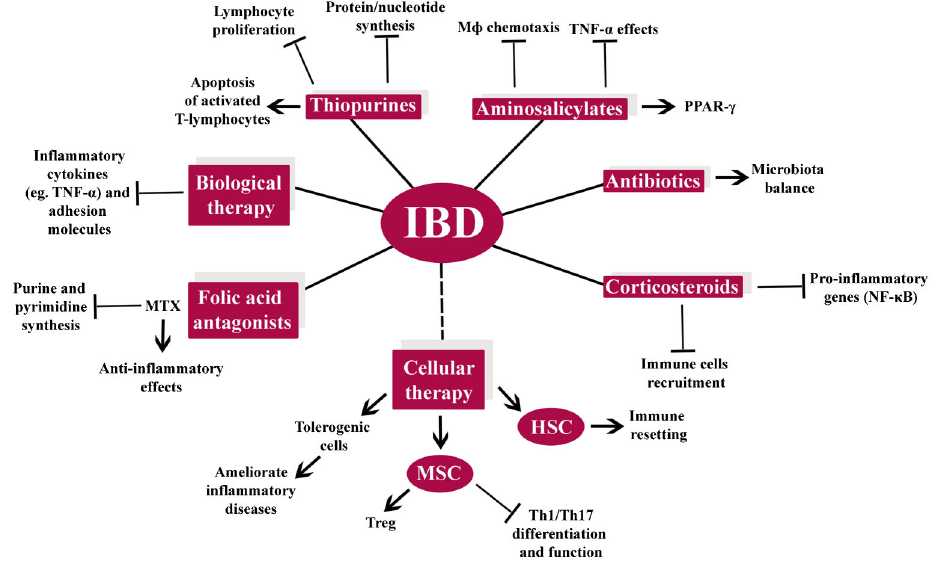
Figure 1. Current and emerging therapies for inflammatory bowel disease (IBD). The classical treatments for IBD include aminosalicylates, antibiotics, corticosteroids, thiopurines, folic acid antagonists (methotrexate) and anti-TNF- a biological agents. All these drugs have different targets that contribute to the regulation of the exacerbated immune responses in Crohn’s disease or ulcerative colitis patients. Continuous lines indicate drugs currently used in IBD treatment while the dashed line is related to the emerging cellular therapy. Arrows: induction or stimulatory events. Blocked arrows: inhibitory actions of the indicated therapy. HSC: hematopoietic stem cell; M W : macrophage; MSC: mesenchymal stromal cells; MTX: methothrexate; NF- k B: nuclear factor k B; PPAR- c : peroxisome proliferator-activated receptor c ; Th: T helper cell; Treg: T regulatory cell; TNF- a : tumor necrosis factor a